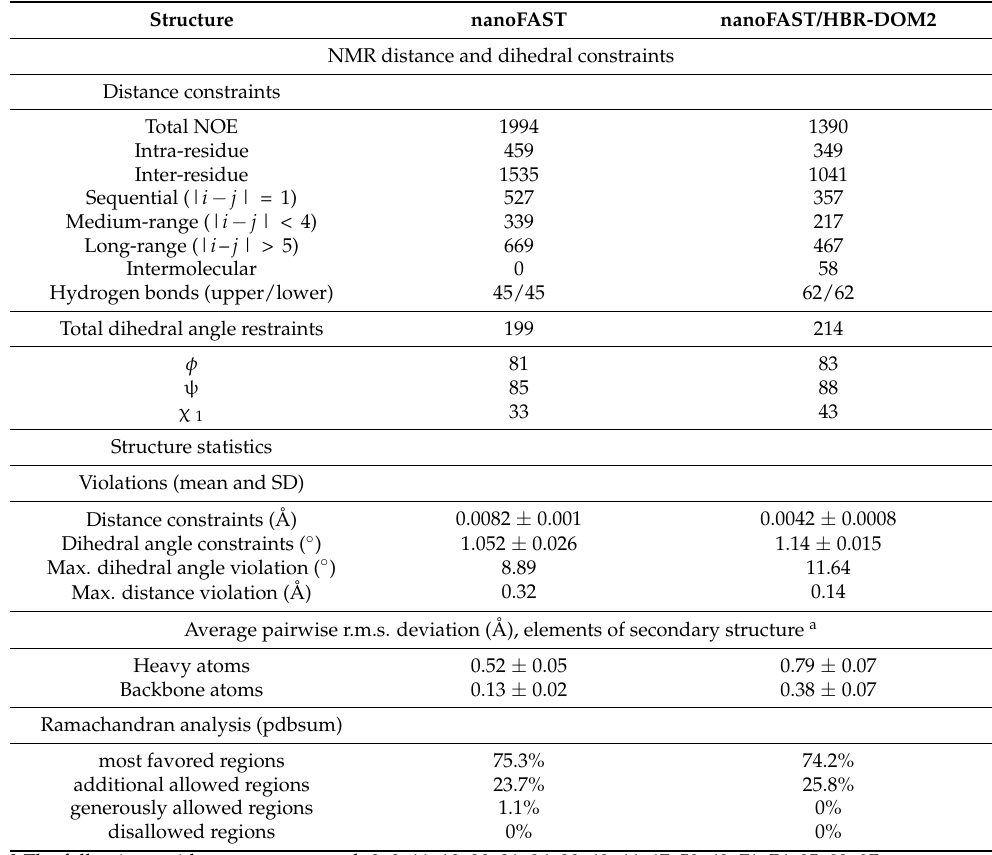
Table 1. Input data and statistics for the obtained spatial structures of nanoFAST and nanoFAST/HBR- DOM2